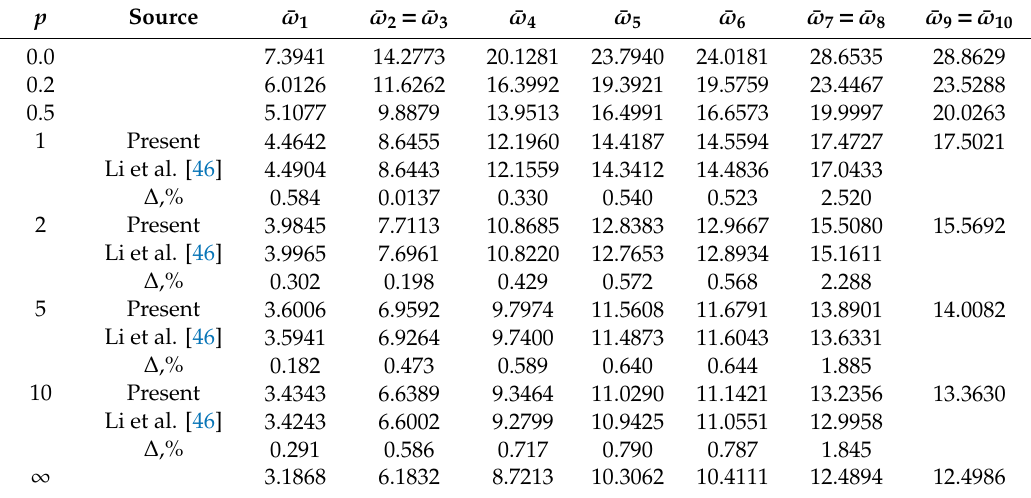
Table 6. The first ten nondimensional frequencies of CCCC SUS304 / Si 3 Ni 4 functionally graded square plates thermally loaded by the nonlinear temperature rise as shown in Figure